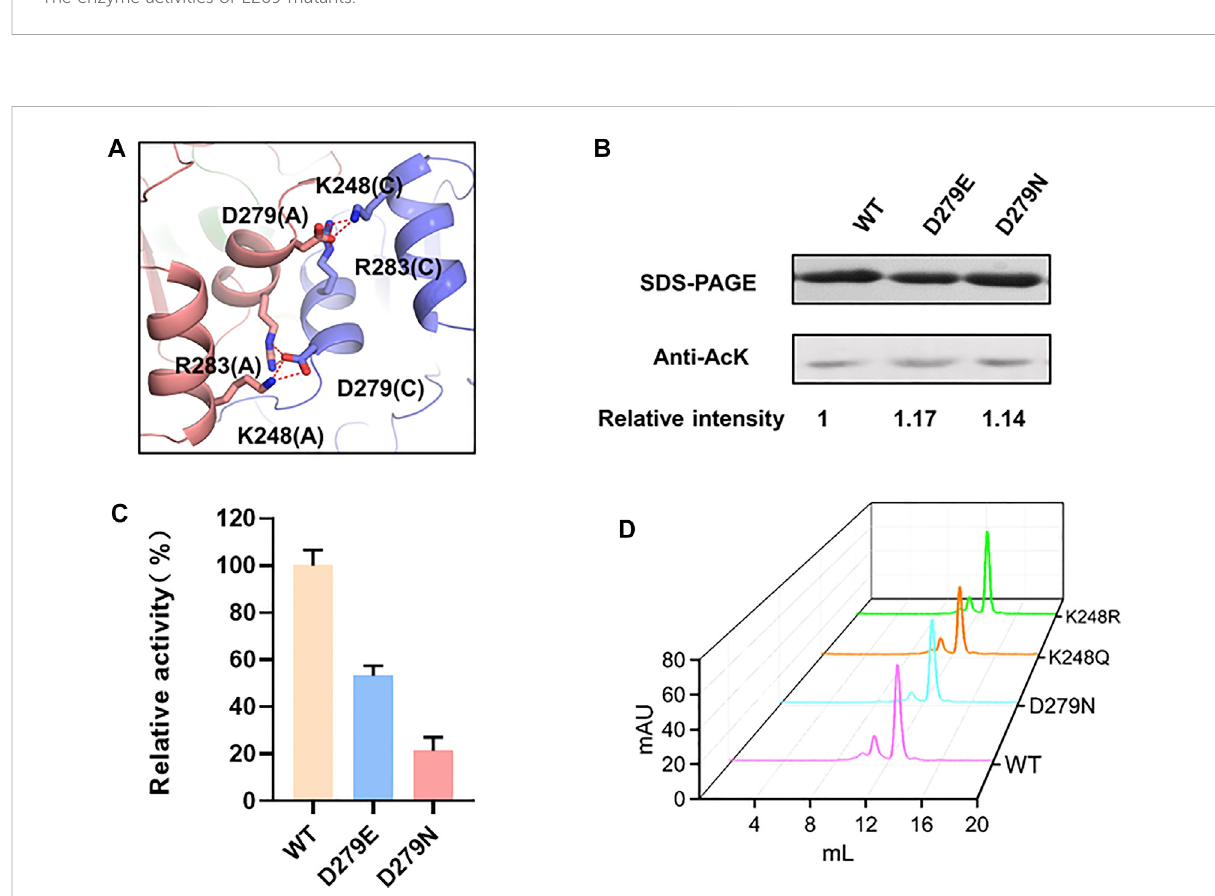
FIGURE 4 The mechanism of K248 acetylation on enzyme activity. (A) The intermonomer salt bridge of K248-D279. (B) The acetylation levels of D279 mutants. (C) The enzyme activities of D279 mutants. (D) Size exclusion chromatograph of LdhA mutants about the K248-D279 salt